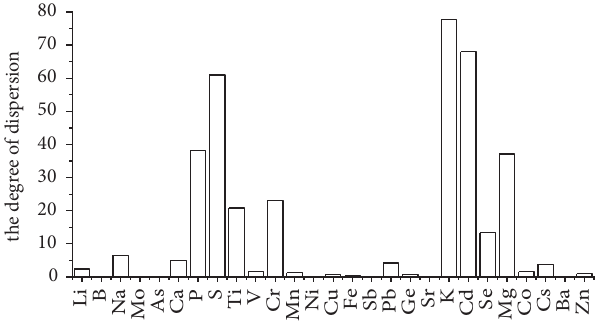
Figure 2: The degree of dispersion.